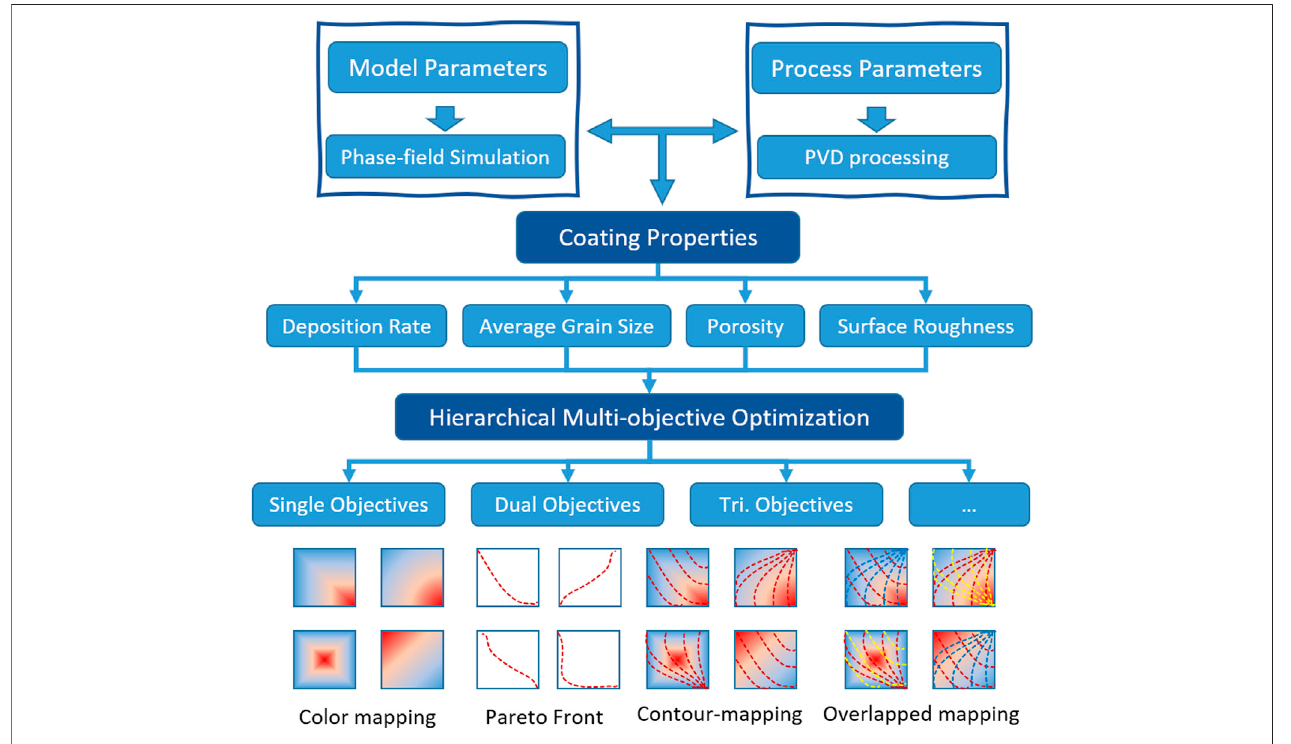
FIGURE 8 | Hierarchical multi-objective decision-making strategy for coatings by PVD